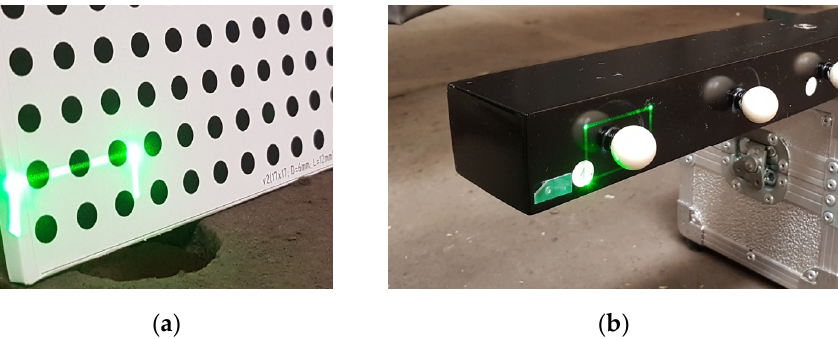
Figure 3. Compared standards: ( a ) calibration board and ( b ) ball-bar standard.